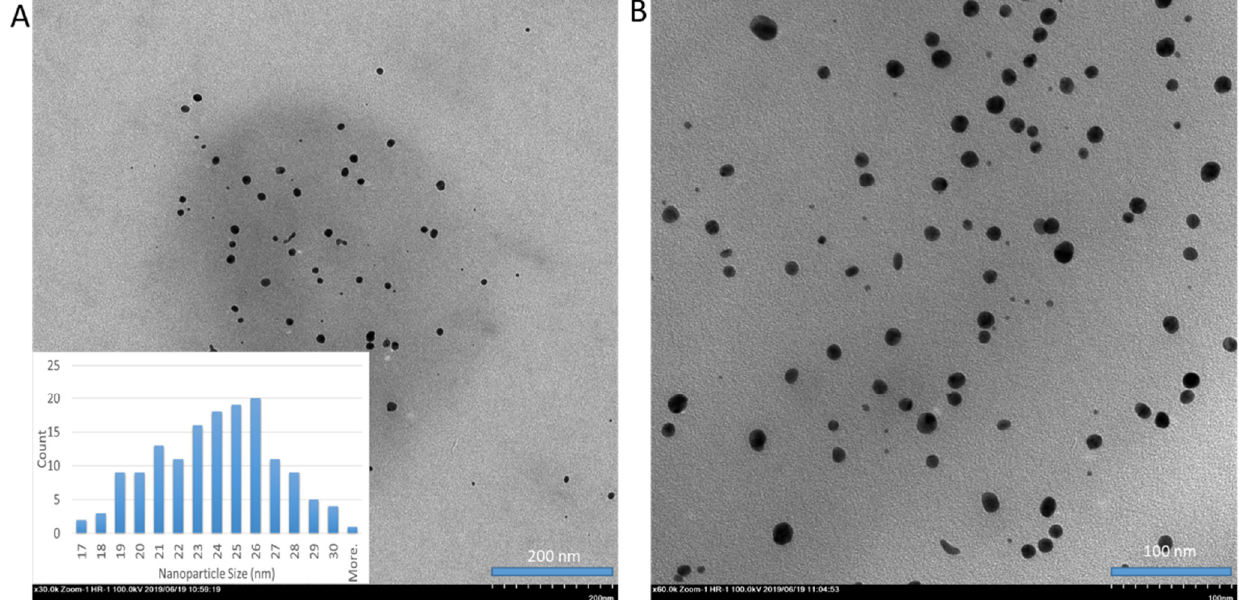
Figure 6. TEM micrographs of gold nanoparticles transferred with n-butylsilane in toluene. (( A ) 30 k zoom ( B ) 60 k zoom). zoom ( B ) 60 k